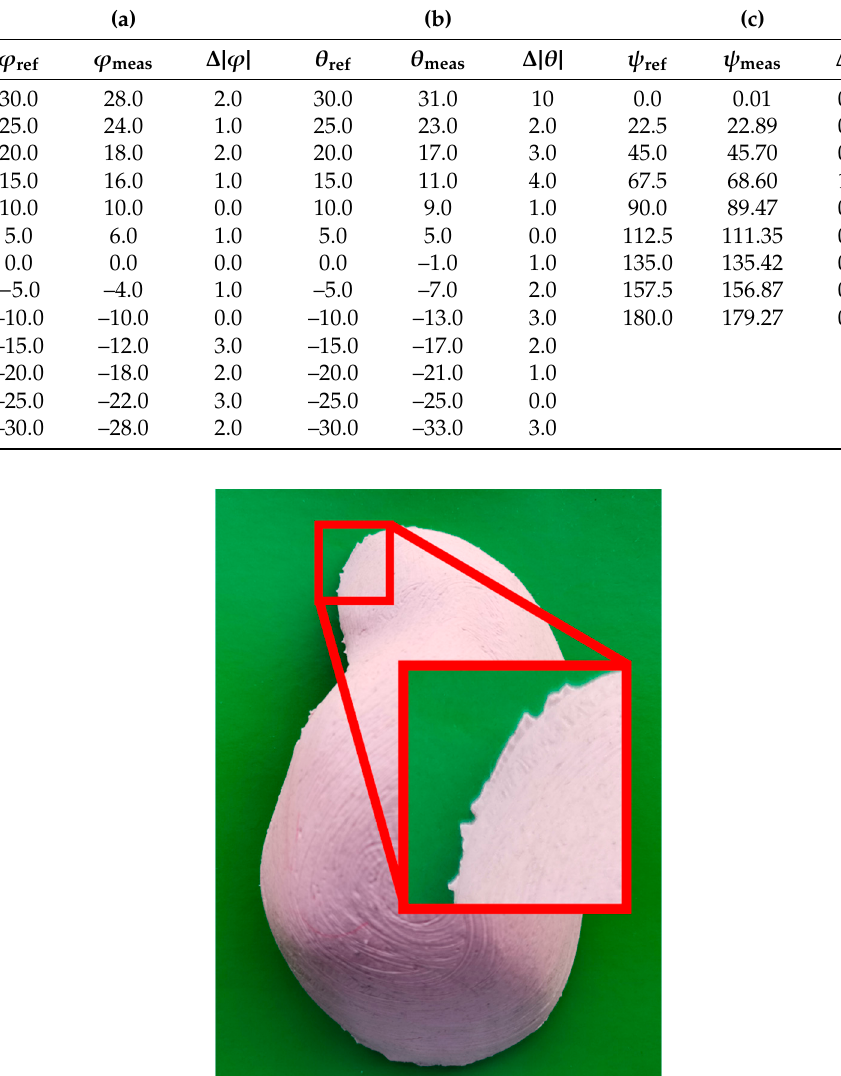
Table 1. Detection accuracy of phantom rotation angles. ( a ) Di ff erence ∆ | ϕ | between reference rotation ϕ ϕ meas about the X axis detected by the system for the phantom placed on the table (Unit: ref and angle degrees, ◦ ). ( b ) Di ff erence ∆ | θ | between reference rotation θ ref and angle θ meas about the Y axis detected by the system for the phantom placed on the table (Unit: degrees, ◦ ). ( c ) Di ff erence ∆ | ψ | between reference rotation ψ ref and angle ψ meas about the Z -axis detected by the system for the phantom placed on the table. (Unit: degrees, ◦ ).